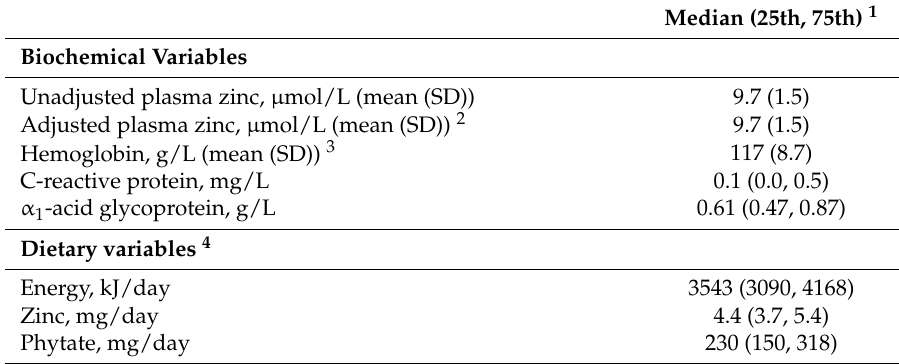
Table 2. Characteristics of toddlers who provided plasma zinc data at 12 months of age ( n =